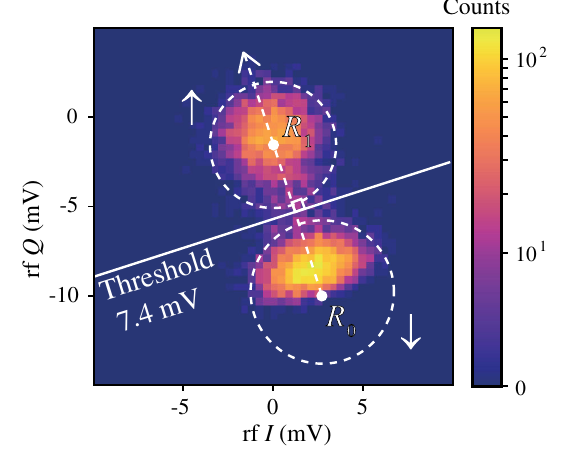
FIG. 7. I - Q histogram of the maximum readout traces ’ re- sponses. A 2D histogram of the maximum response of 10 000 readout traces was constructed in I - Q space. The areas within the two white, dotted circles centered around R 0 and R 1 depict the distributions of the entire traces that the maximum signals had been sampled from. The histogram shows two distinct distribu- tions corresponding to spin-up and -down that can be separated by a perpendicular threshold 7.4 mV from R 0 to distinguish the spin states during electrical